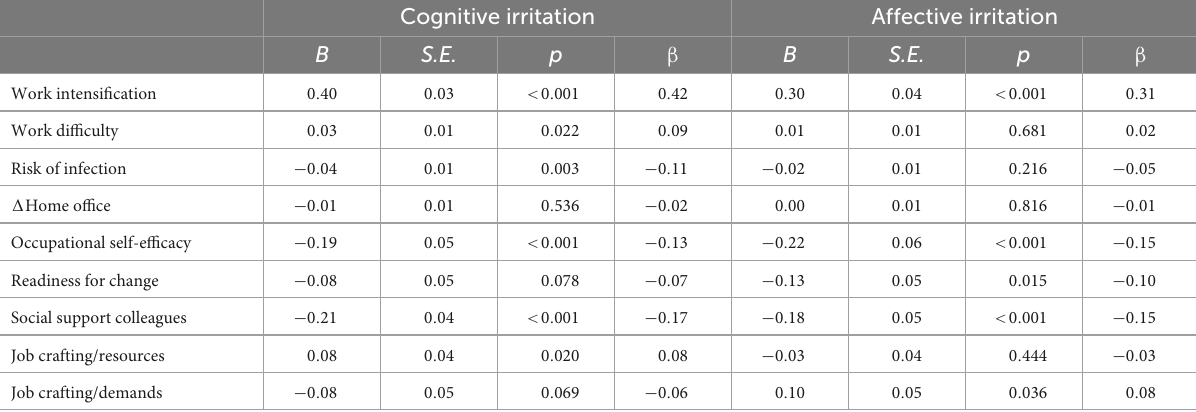
TABLE 1 Path analysis with two dependent variables.